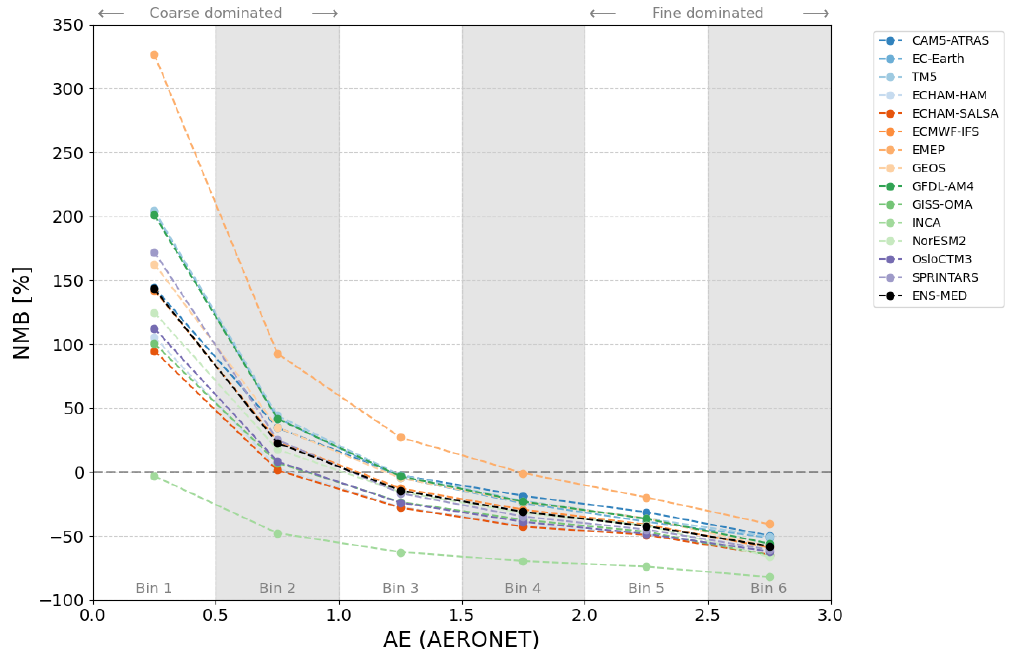
Figure 7. AE model biases in different AE regimes. The biases for each model ( y axis) are retrieved by co-location with AERONET observations, using only measurements that fall into the respective AE